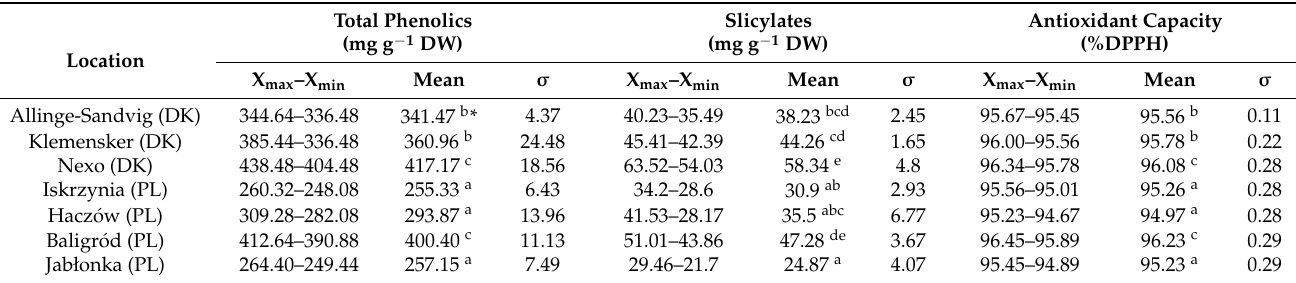
Table 2. Chemical parameters of meadowsweet inflorescences.